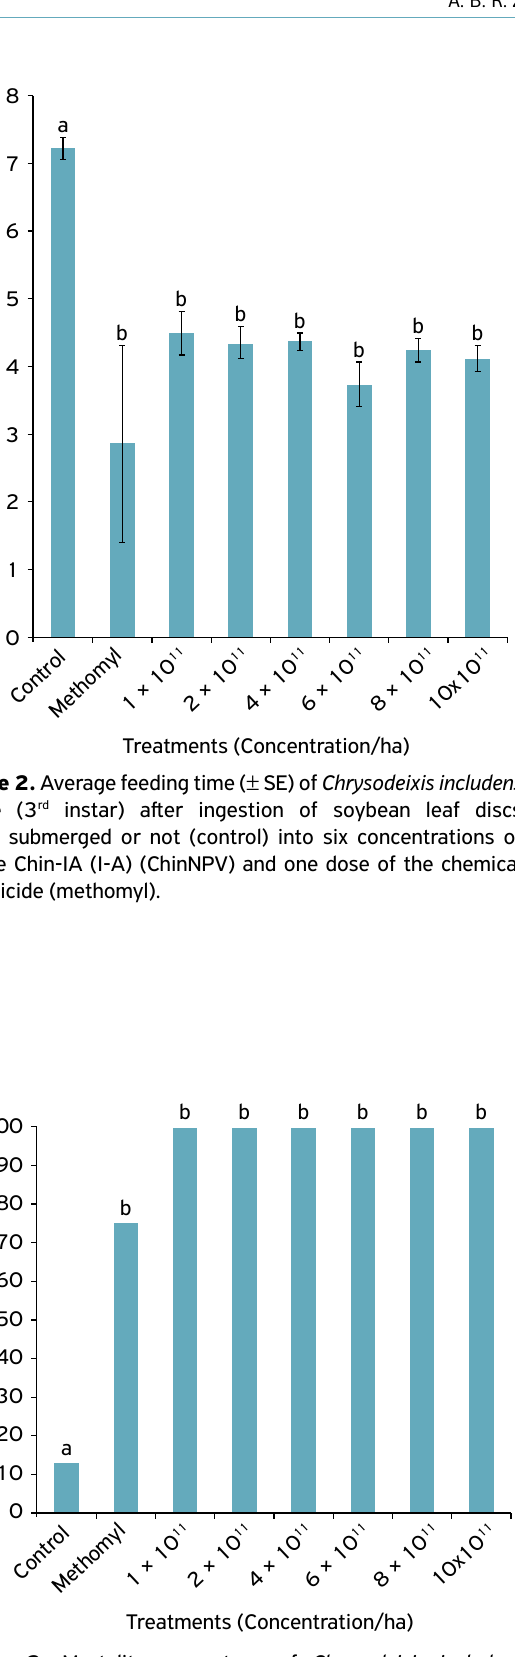
Figure 3. Mortality percentage of Chrysodeixis includens larvae (3 rd instar) after ingestion of soybean leaf discs either submerged or not (control) into six concentrations of isolate Chin-IA (I-A) (ChinNPV) and one dose of the chemical insecticide